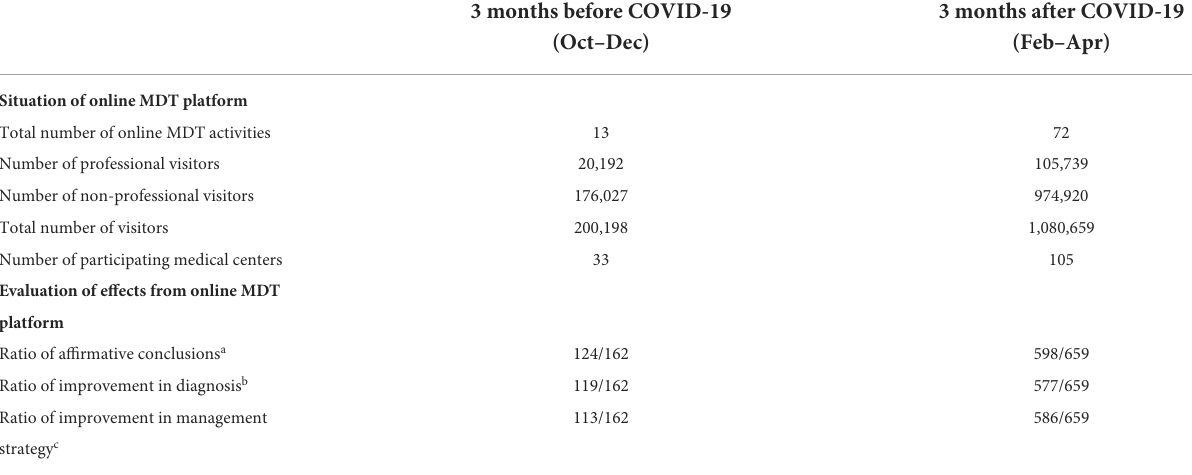
TABLE 1 Comparison of the operation status of the Internet-based multidisciplinary management in patients with genitourinary cancer in China before and after the COVID-19